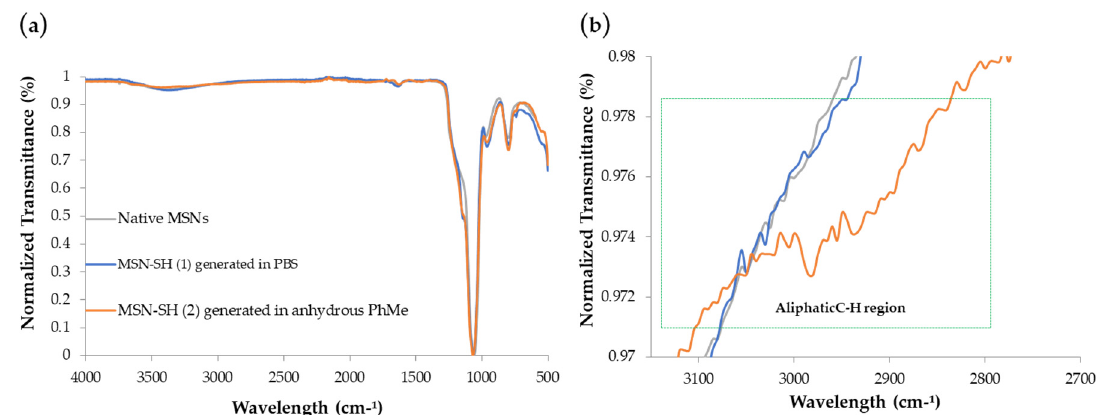
Figure 3. ( a ) FT-IR spectra of MSN-SH (1) synthesized in PBS pH 5 and MSN-SH (2) synthesized in anhydrous PhMe. ( b ) Enlarged region of spectrum (2800 cm − 1 to 3150 cm − 1 ) suggesting a greater presence of organic functionalities on the surface of MSN-SH (2), as compared to MSN-SH (1).